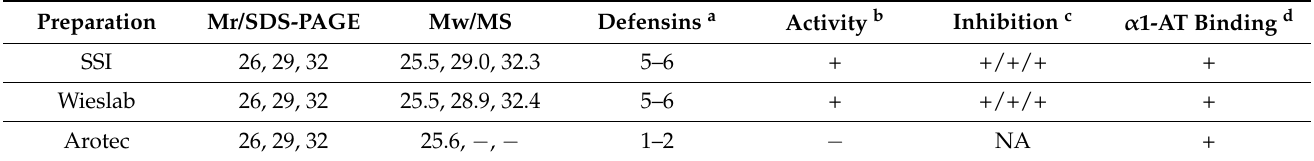
Figure 1. SDS analysis of PR3 preparations. ( a ) Coomassie Brilliant Blue staining. Lanes 1, 2: Arotec PR3, lanes 3, 4: Wieslab PR3, lanes 5, 6: SSI PR3. Samples were boiled with sample buffer with DTT (lanes 1, 3, 5) or without DTT (lanes 2, 4, 6) and run on a 16 % Tricine gel. ( b ) Silver staining. Lane 1: Wieslab PR3, lane 2: SSI PR3, lane 3: Arotec PR3. Samples were boiled with sample buffer with DTT and run on a 4–20% Tris-glycine SDS-PAGE gel. PR3 bands with none, one or two covalently bound defensins are indicated with “0, 1, 2” and free defensins with “Def”. Table 1. Characteristics of PR3